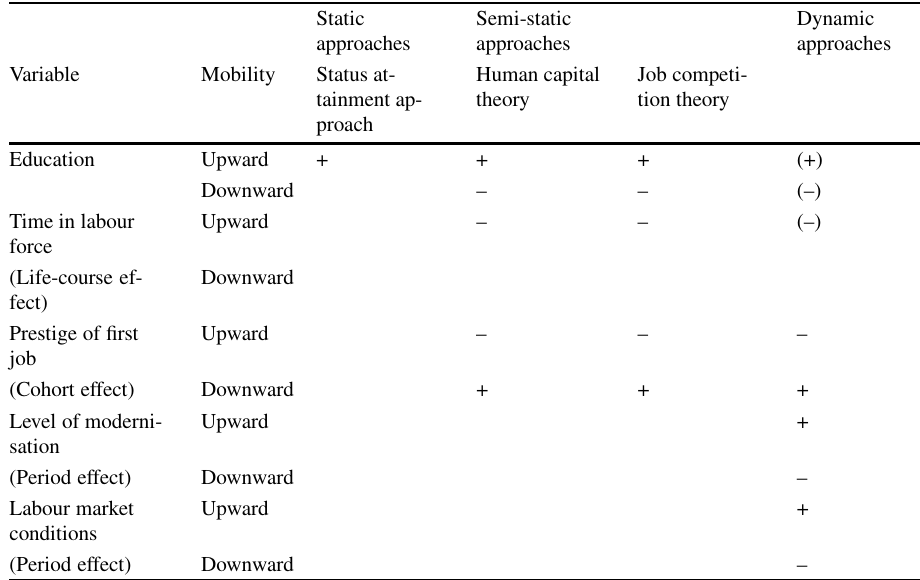
Table 1 Summary of hypothe- sised